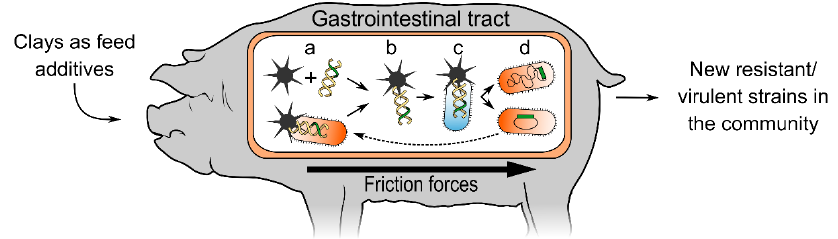
Figure 1. Clay-mediated DNA transfer in livestock. Clay additives in animal feed form complexes due to friction forces that may promote the release of DNA from bacteria. This free DNA can then be adsorbed by clay (a). The resulting DNA-clay complexes (b) penetrate other microbes, internally delivering the carried DNA (c). This may result in the acquisition of new virulence genes and/or antibiotic resistance determinants (d). Both commensal and pathogenic bacteria may act as recipients or donors and acquire traits that compromise the treatment of